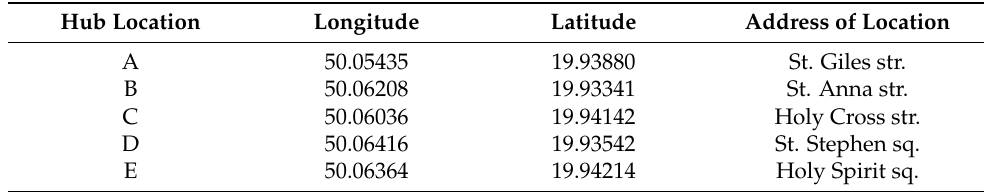
Table 1. The alternative locations of a loading hub in the Old Town district of Krakow. Hub Location